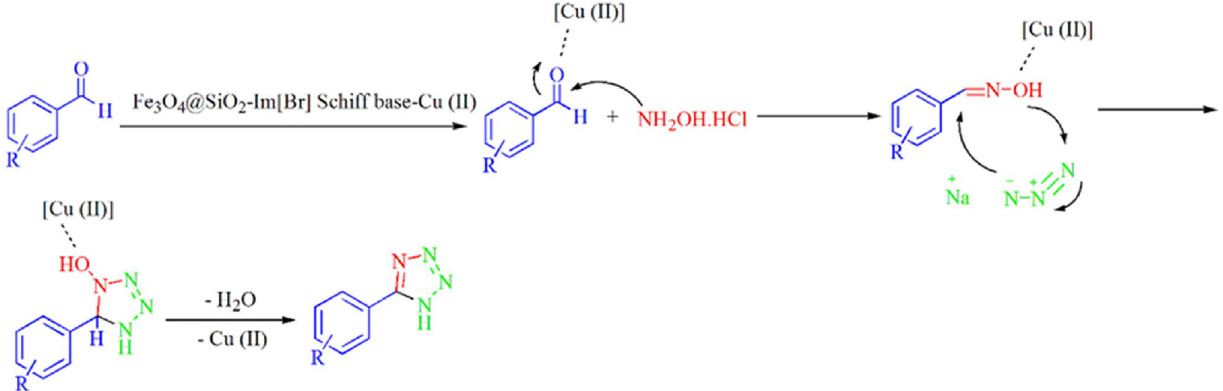
Figure 14. The proposed mechanism for the synthesis of 5-aryl 1 H- tetrazole